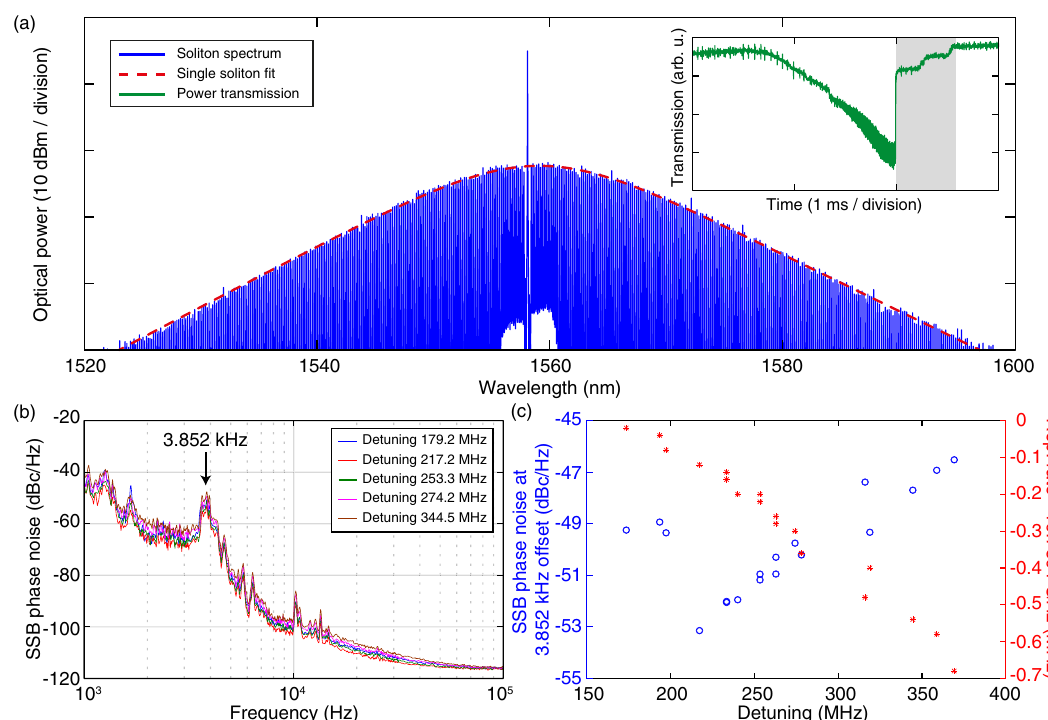
Fig. 4 Single soliton generation in the racetrack microresonator with Euler bends, and the phase noise characterization of soliton repetition rate. a Single soliton spectra of 19.8 GHz repetition rate. No prominent dispersive wave features caused by avoided-mode crossings (AMXs) are observed. The single soliton spectrum fi t shows a 3-dB bandwidth of 16.3 nm, corresponding to a pulse duration of 156 fs. The estimated on-chip continuous-wave (CW) pump power is 55.7 mW. Note that a band-pass fi lter is used to fi lter out the EDFA ’ s ampli fi ed spontaneous emission noise in the pump laser, and a fi ber Bragg grating is used to fi lter out the pump laser in the soliton spectra. Inset: When the pump laser scans across the resonance, a soliton step of ~0.5 ms length in the microresonator transmission is seen (marked in the gray zoom). b Single-sideband (SSB) phase noise measurement with different soliton detuning values. No prominent phase noise change due to a quiet point operation is observed. The feature at 3.852 kHz Fourier offset frequency is caused by the diode laser pump 52 . c SSB phase noise at 3.852 kHz Fourier offset frequency and measured repetition rate shift with different soliton detuning values. The absence of a strong quiet point is due to the inhibited dispersive wave generation that is caused by the suppressed spatial mode interaction and avoided-mode crossings.